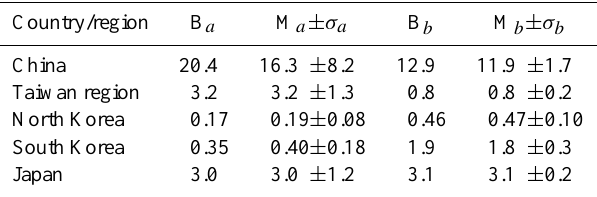
Table 8. HFC-134a emissions (kt/yr) per country/region for the year